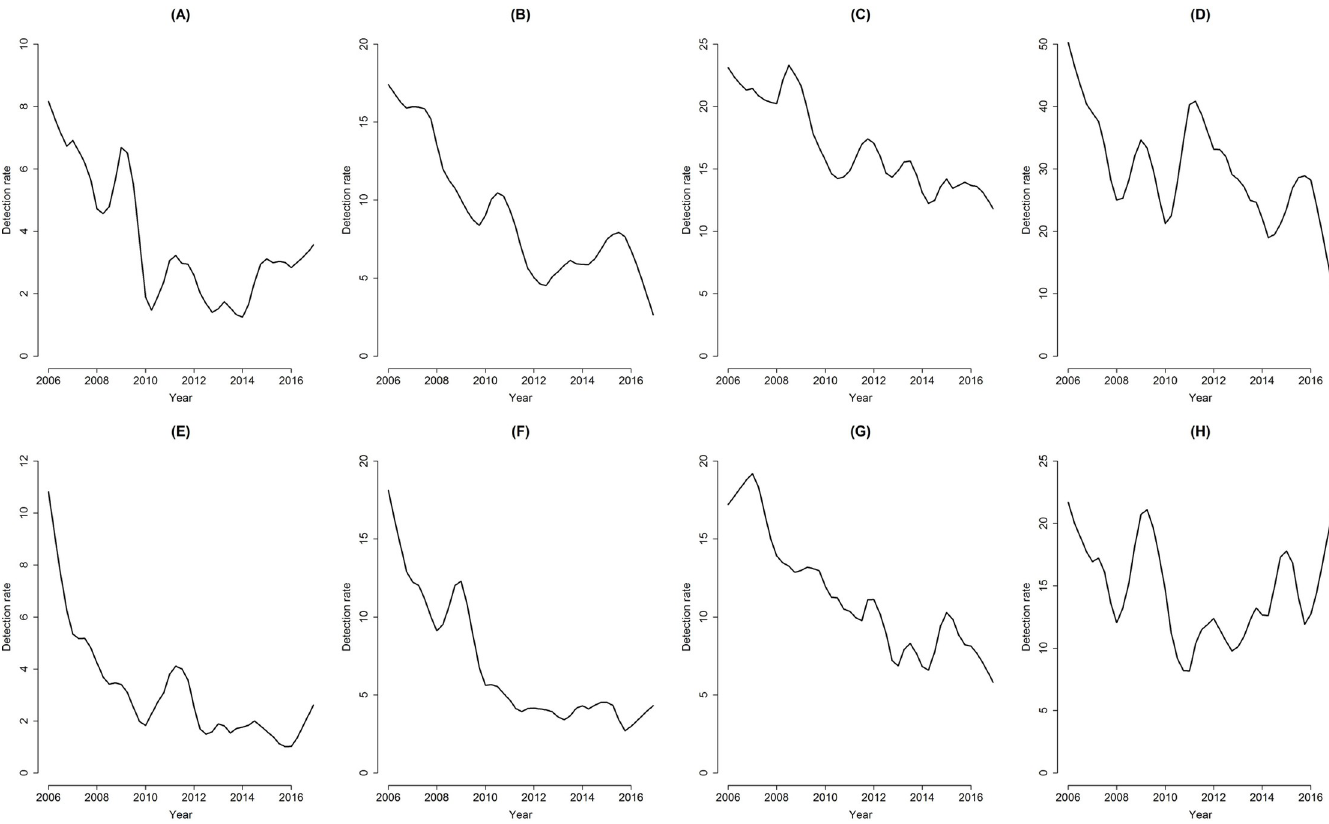
Fig 4. Trends of leprosy according to sex and age groups, Imperatriz, MA, Brazil (2006–2016). (A) Men younger than 15 years old; (B) Men aged between 15 and 29 years old; (C) Men aged between 30 and 59 years old; (D) Men aged 60 years old or over; (E) Women younger than 15 years old; (F) Women aged between 15 and 29 years old; (G) Women aged between 30 and 59 years old; (H) Women aged 60 years old or over.